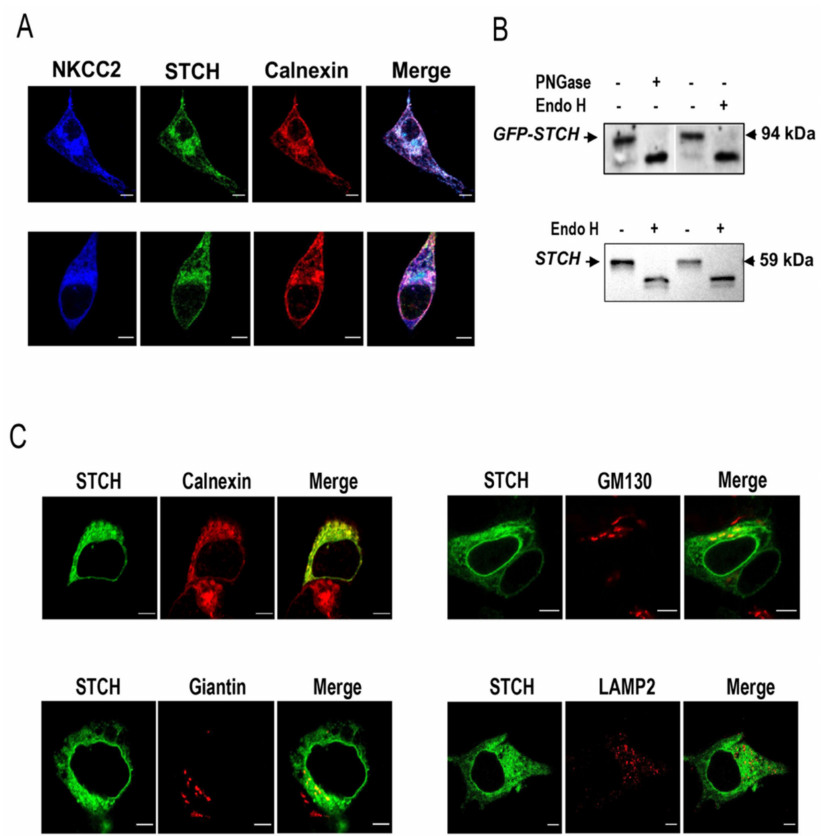
Figure 2. STCH co-localizes with NKCC2 mainly at the Endoplasmic Reticulum. ( A ) Intracellular localization of NKCC2 and STCH in HEK cells. All panels are fluorescence micrographs of HEK cells overexpressing NKCC2 tagged with myc and STCH tagged with GFP. After transfection, cells were fixed and immunostained with mouse anti-Myc and rabbit anti-calnexin (ER marker) antibodies, and analyzed using a confocal laser scanning microscope. The merge color indicates overlap between the Myc tag of NKCC2 protein (Alexa Fluor 647, Blue), the GFP tag of STCH (green) and the ER marker (Alexa Fluor 555, red) and represents co-localization of the proteins. Bars, 5 µ m. ( B ) N -glycosidases digestion of STCH in HEK cells. Exogenous STCH-GFP ( upper panel ) and endogenous STCH ( lower panel ) in lysates from cells overexpressing STCH-GFP were digested with Endo H and/or PNGase F and analyzed by Western blotting. ( C ) Comparison between the cellular localization of STCH and several organelle markers. Cells transfected with NKCC2 tagged with myc and STCH tagged with GFP were fixed after transfection, immunostained with anti-calnexin (ER marker) or -Giantin (Golgi marker) or -GM130 (Cis Golgi marker) or -LAMP2 (Lysosomal marker) antibodies and visualized with GFP tag of STCH (green) and Alexa Fluor 555 conjugated secondary antibodies for each organelle marker. Analysis was performed by confocal laser scanning microscopy. Bars, 5 µ